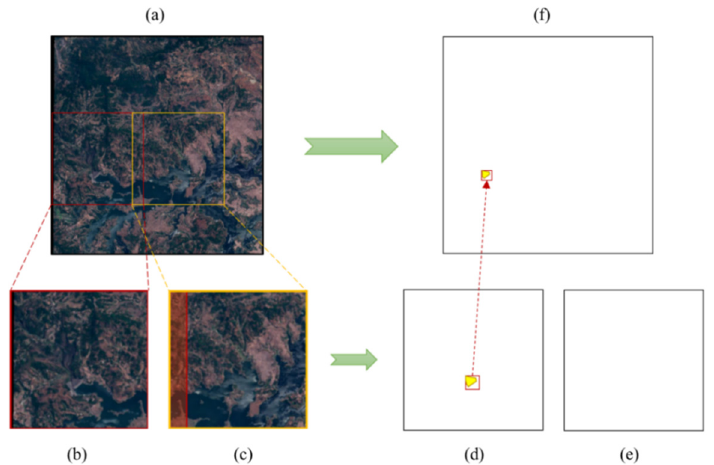
Figure 6. An example of pre-processing on high-resolution satellite imagery and post-processing for the results of dam detection and segmentation. ( a ) The original image; ( b ) one image patch; ( c ) the image patch with a 10% overlap that is adjacent to ( b ); ( d ) dam extraction result of ( b ), which has a dam. The red rectangle is the result of dam detection, and the yellow irregular polygon is the result of dam segmentation. ( e ) Dam extraction result of ( c ), which has no dam targets; ( f ) dam extraction result of the original image.